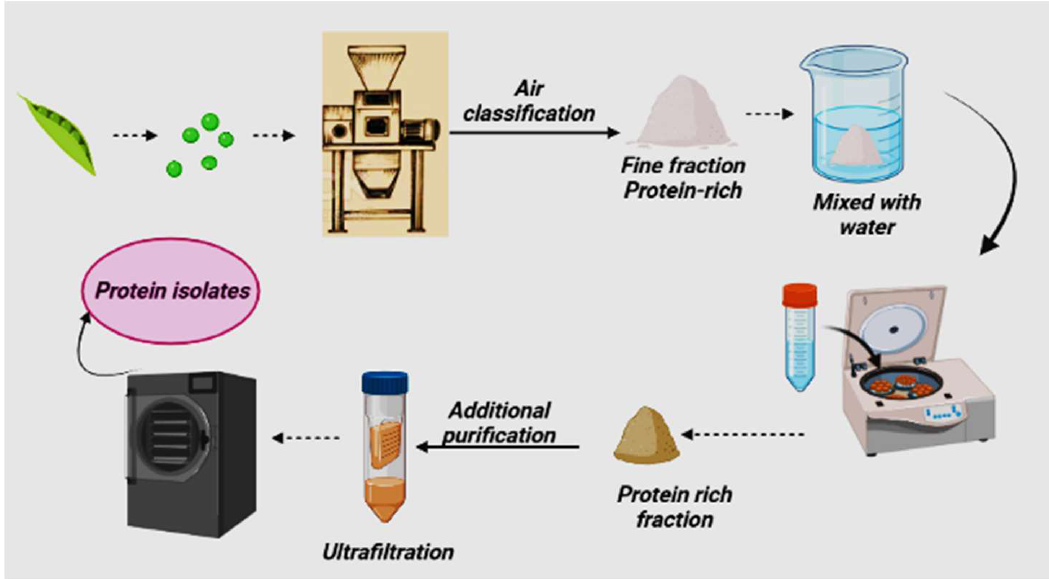
Figure 4. Extraction of pea protein by mild fractionation method. Table 1. Various extraction methods, yield, and application.